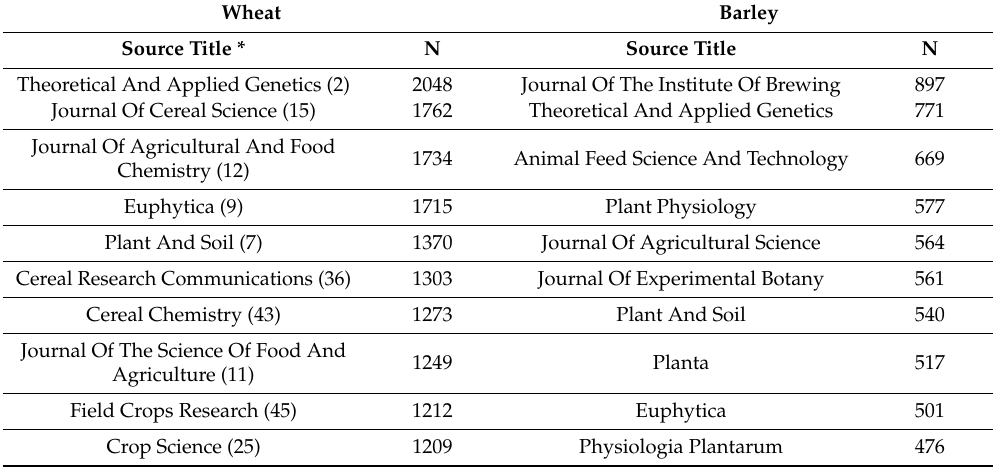
Table 3. Top 10 sources of publications in the wheat and barley research fields. Journals included in both lists are in bold lettering.